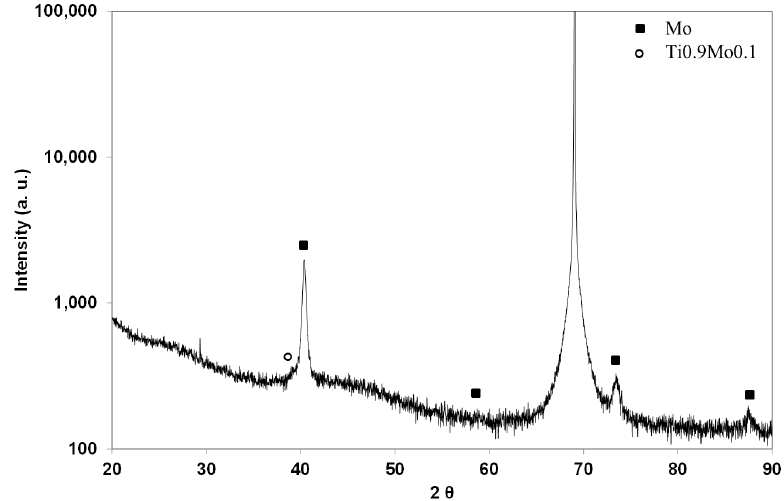
Figure 2. X-ray diffraction pattern of untreated Mo–Ti, 250–250 nm, thick bilayer film.